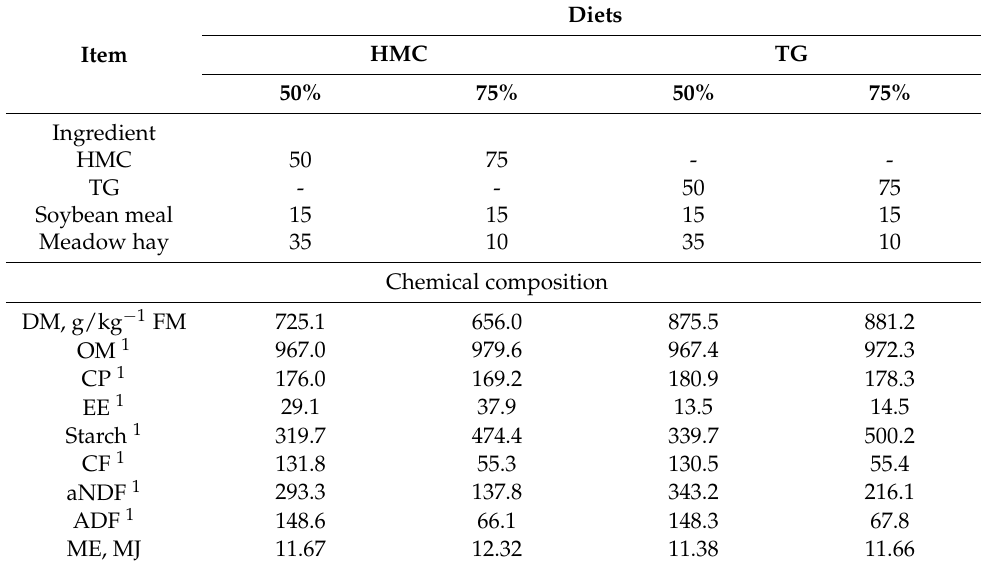
Table 2. Ingredients (%DM) and chemical composition of the